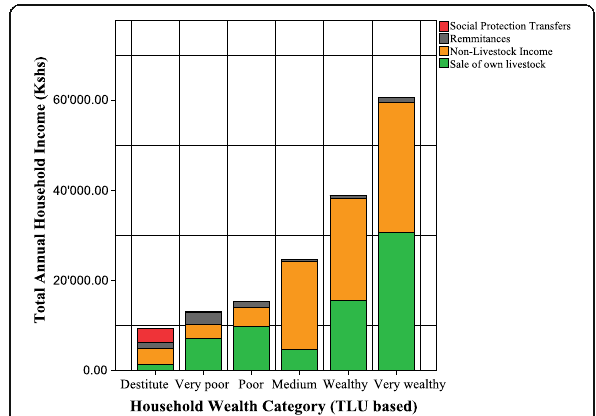
Figure 5 Cash total household income composition among the different wealth